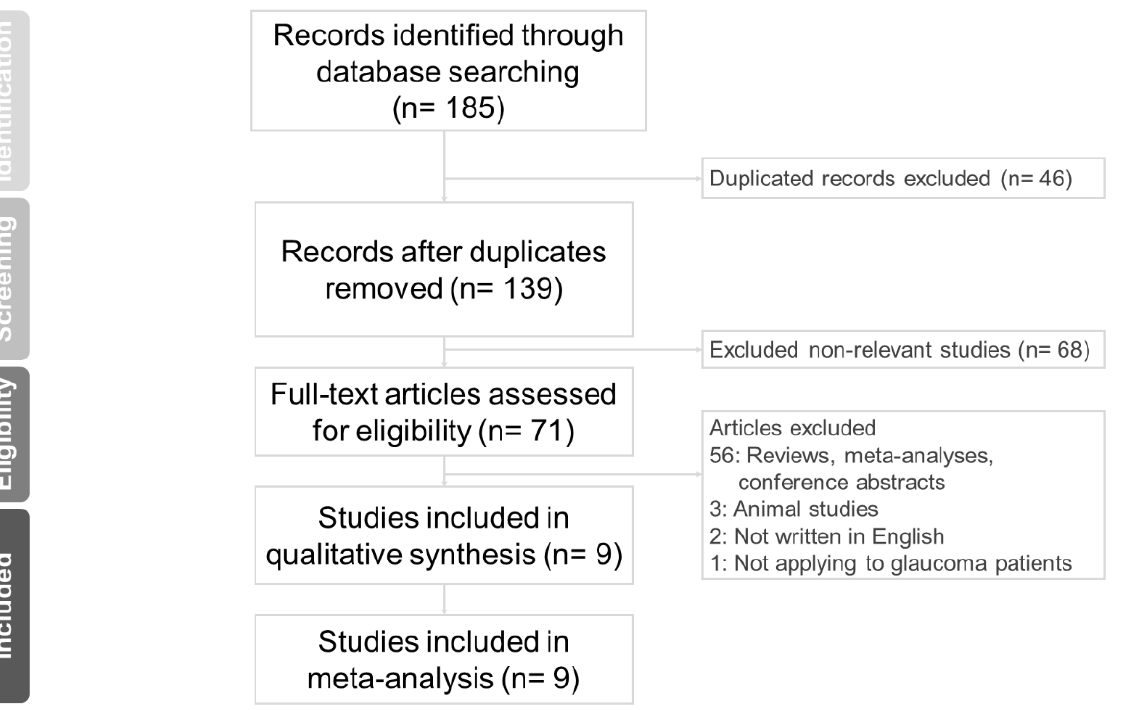
Figure 1. Study retrieval process according to the Preferred Reporting Items for Systematic Reviews and Meta-Analysis (PRISMA) statement.